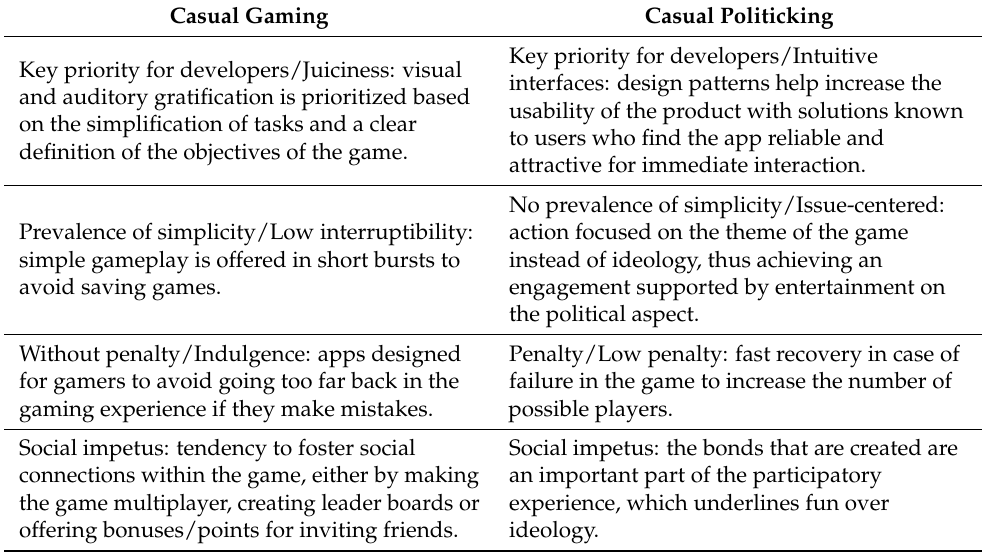
Table 1. Proposal for a comparison between the principles of participation in “casual games” and “casual politicking”.